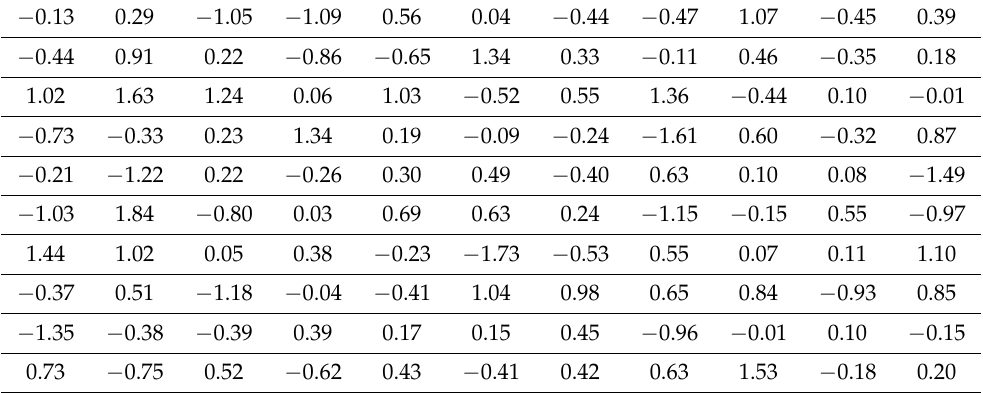
Table A1. Hidden layer weights (11 input × 10 hidden neurons).